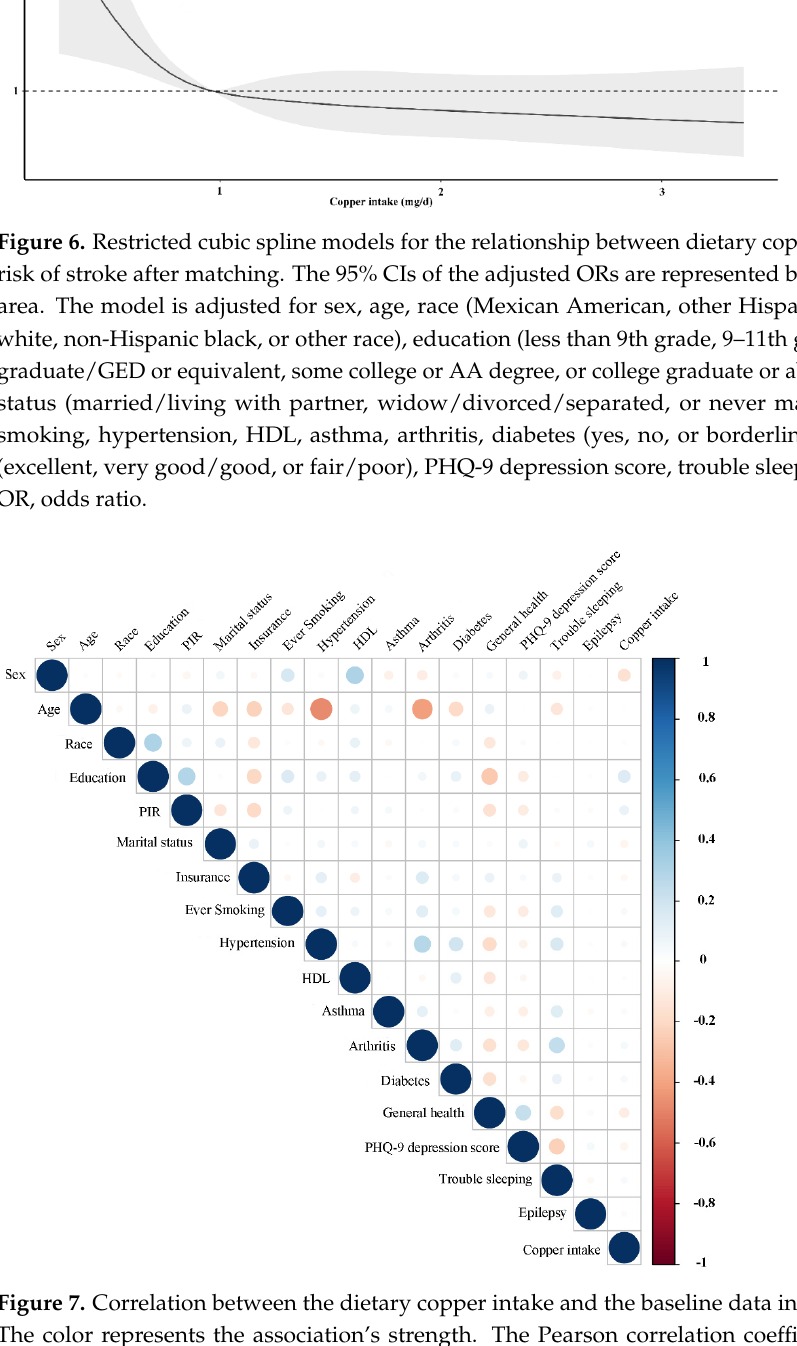
Figure 7. Correlation between the dietary copper intake and the baseline data in the control group. The color represents the association’s strength. The Pearson correlation coefficient was used to calculate the correlation.